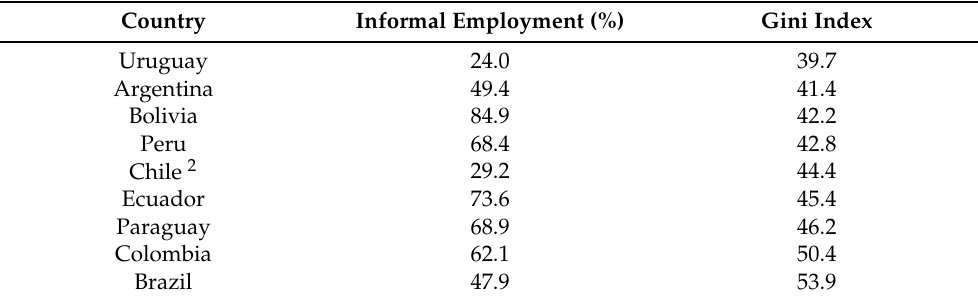
Table 1. Proportion of informal employment related to total employment (2019) and Gini Index (2018). Source: Ilostat (2019) and World Bank (2018) 1